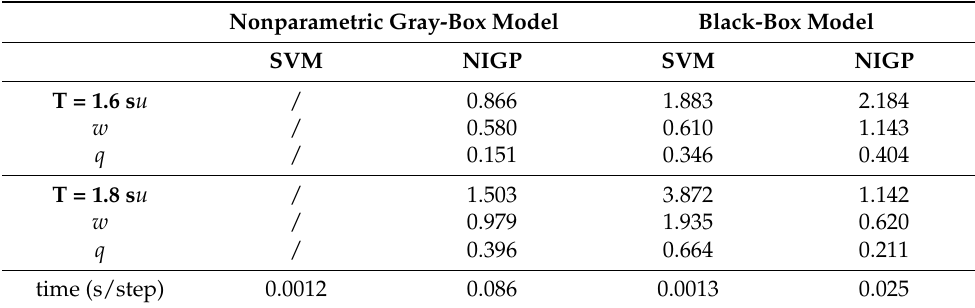
Figure 10. Comparisons of results of the WEC predicted motion; T = 1.6 s. Table 6. Estimation of forecast accuracy by RMSE and computation time for the WEC motion with the wave period 1.6 s and 1.8